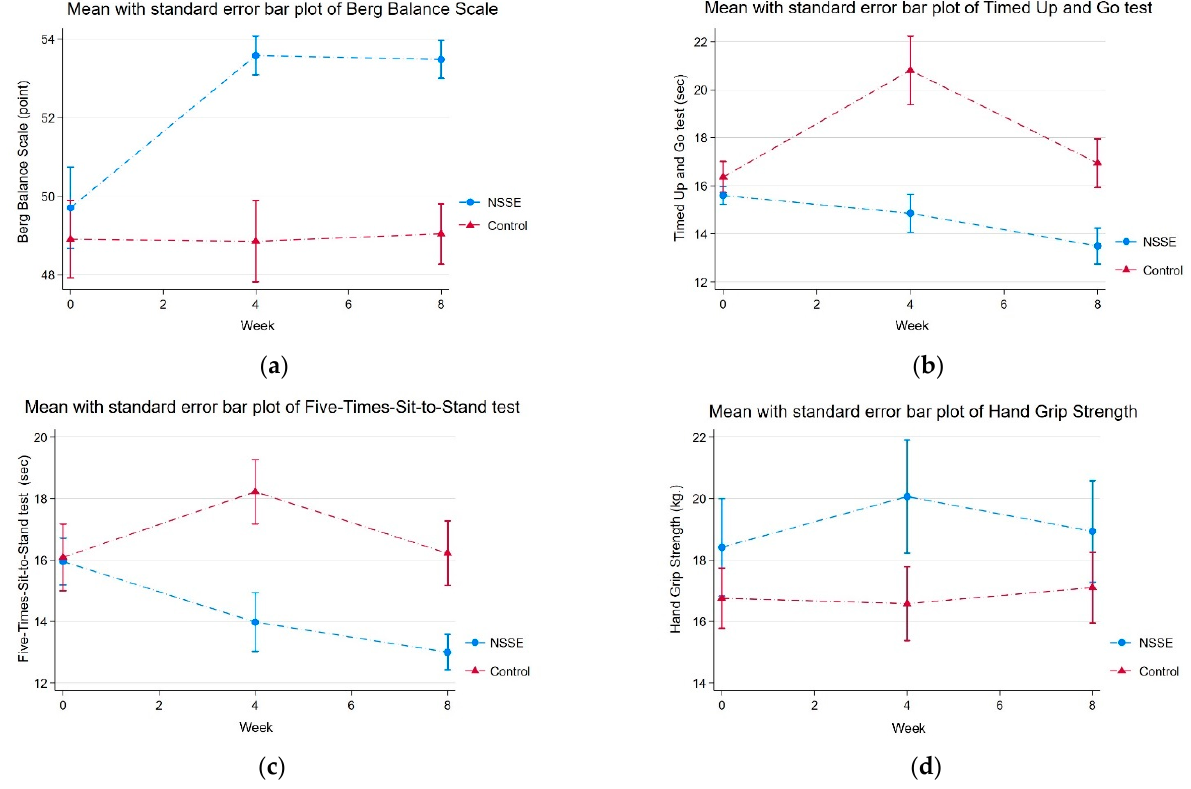
Figure 4. Changes in physical performances summarized by the mean with standard error bar plots. ( a ) Changes in the Timed Up and Go test; ( b ) changes in the Berg Balance Scale; ( c ) changes in Five Times Sit to Stand; ( d ) changes in hand grip strength.